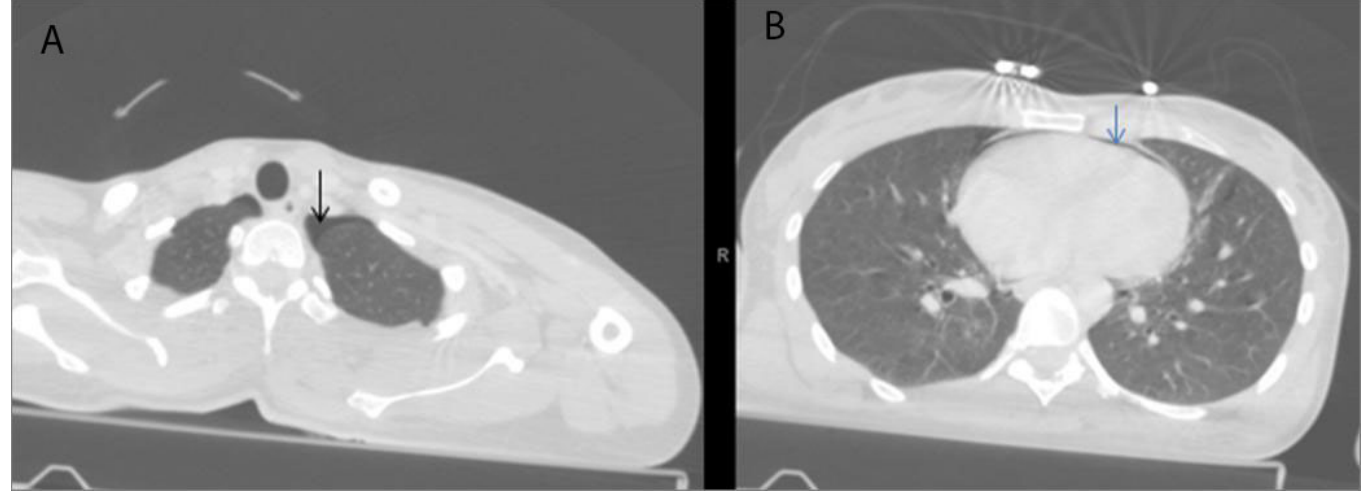
Figure 1. Thoraco-abdominal computed tomography showing pneumothorax, A, and pneumopericardium,